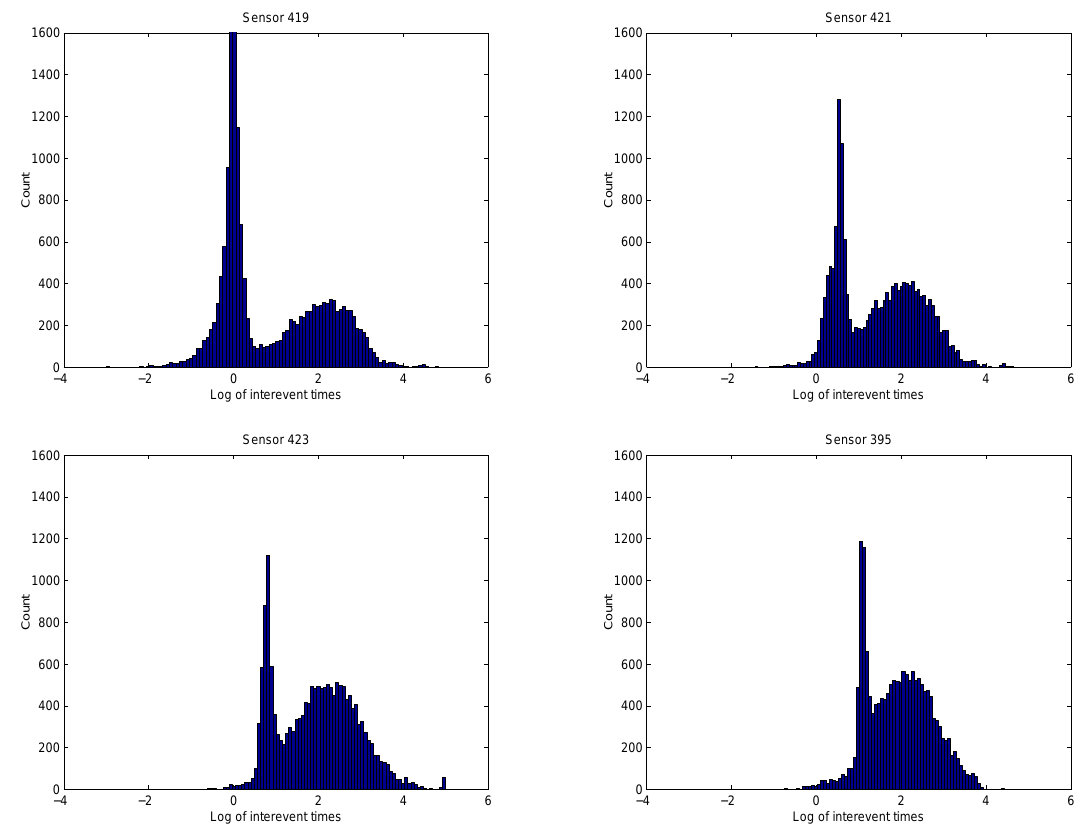
Figure 3. Left to right, top to bottom: Histogram of the logarithm of inter-event times (relative to firings of sensor 418) for four sensors along a MERL corridor (See Section 5). The sharp peak caused by people walking down the corridor and setting off the sensors in succession, is clearly seen as a gradual